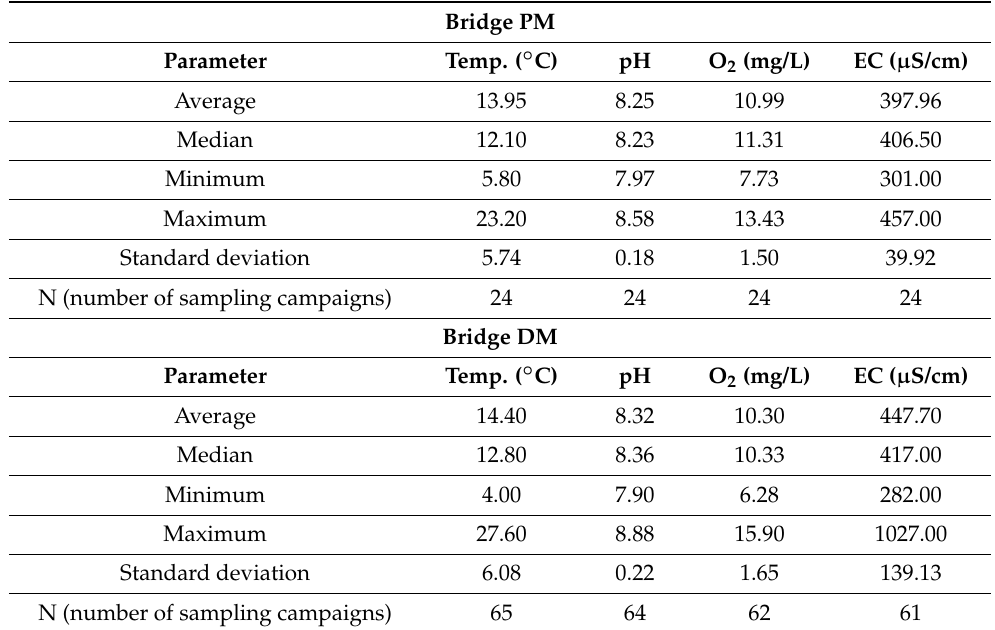
Table 1. Basic statistical values of in-situ parameters of the Sava